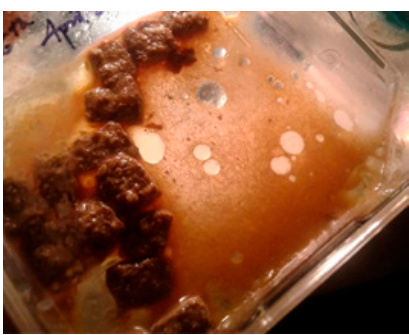
Fig. 4 Infective Juvenile in Semi solid Dog Feed